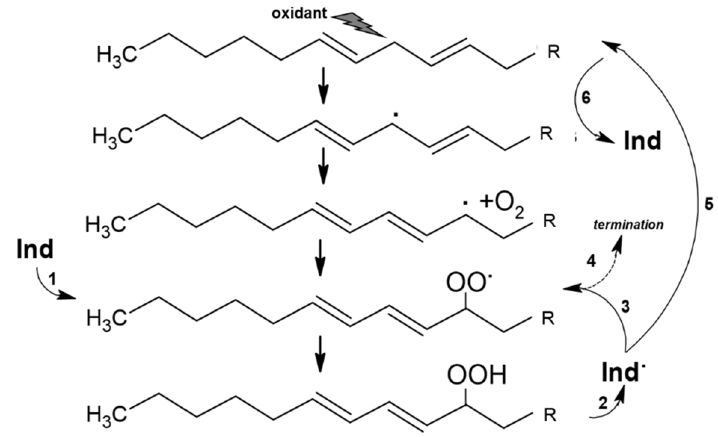
Figure 2. Reaction of Indicaxanthin (Ind) with lipoperoxyl radicals and possible re ‐ cycling of Indicaxanthin short ‐ lived radical intermediate (Ind). Ind reduces a lipoperoxyl radical (1) generating a stable lipid hydroperoxide and Ind. (2). The latter can react with a second lipoperoxyl radical (3) in a termination reaction (4) or can be reduced by reaction with polyunsatured fatty acid (5) to regenerate Ind and a lipid carbon centered radical (6) in a pro ‐ oxidation reaction.